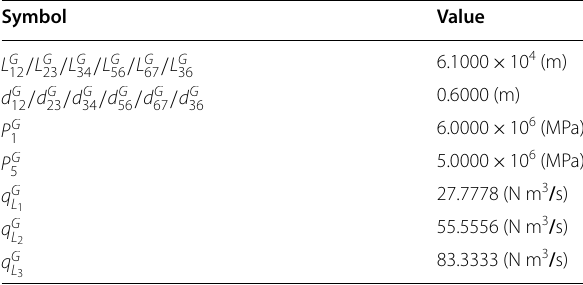
Table 3 Unit cost of gas storage c n